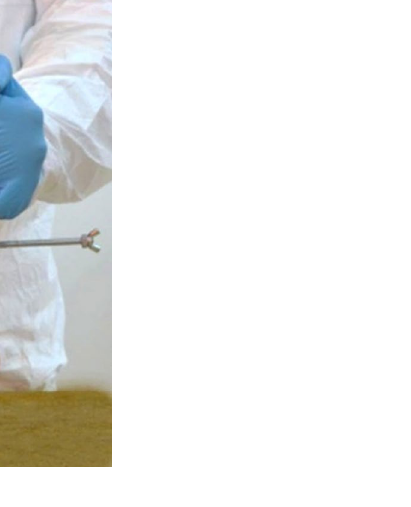
Figure 1. C0-C2 specimen: starting set up of the